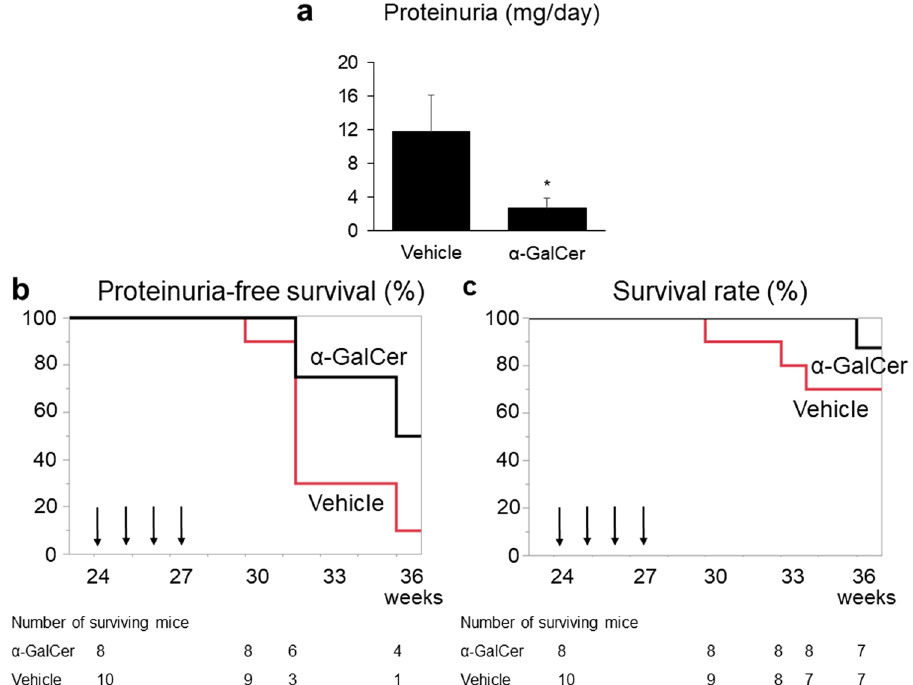
Figure 1. The effects of repeated alpha-galactosylceramide ( α -GalCer) administration on proteinuria and survival rates. ( a ) The levels of proteinuria in each group, measured 8 weeks after the last α -GalCer or vehicle injection ( n = 5–7 in each group). * p < 0.05 compared with the vehicle group. ( b ) The percentages of mice with free of proteinuria and ( c ) the survival rate in the α -GalCer and the vehicle groups ( n = 8 and 10, respectively). Arrows show the timing of when the mice were injected with α -GalCer or